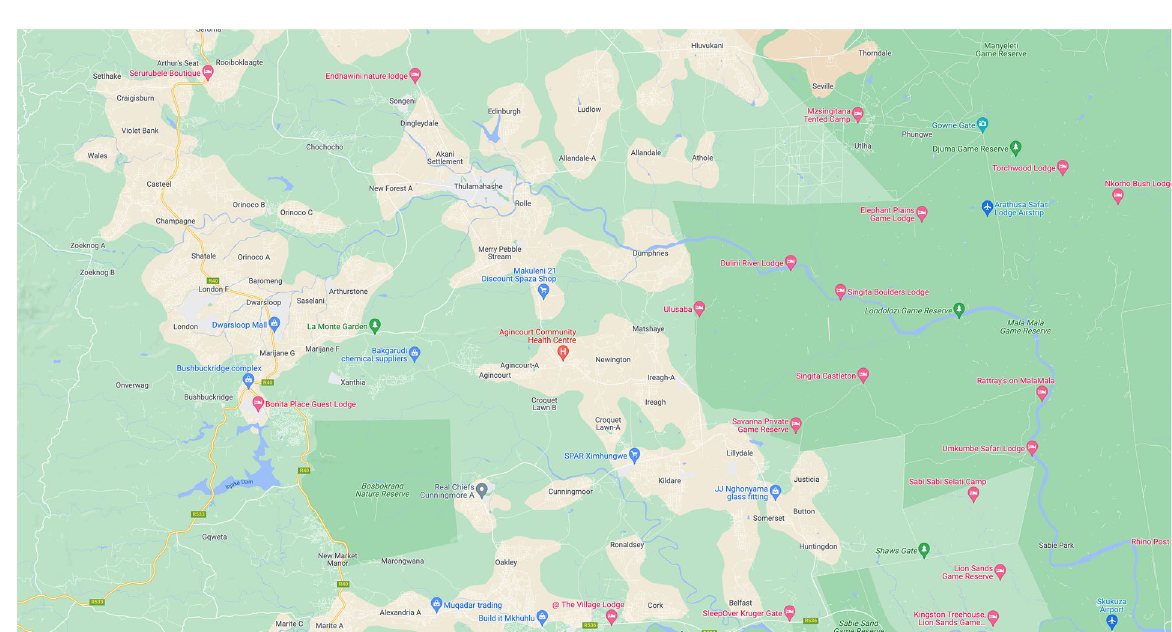
Fig. 1 Study area including Agincourt sub-district and Skukuza Airport. This fi gure is not copyrighted and reproduced with acknowledgement of Google